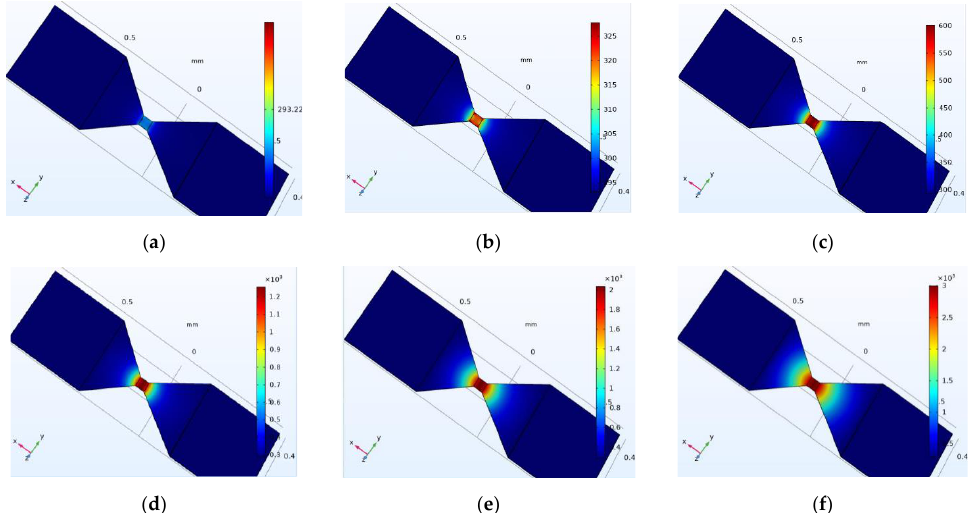
Figure 10. Temperature rise in bridge area of solid-state ON – OFF switch control layer changes with time. ( a ) time = 0 µ s, ( b ) time = 0.15 µ s, ( c ) time = 1.75 µ s, ( d ) time = 6.7 µ s, ( e ) time = 27.05 µ s, ( f ) time = 57.15 µ s.